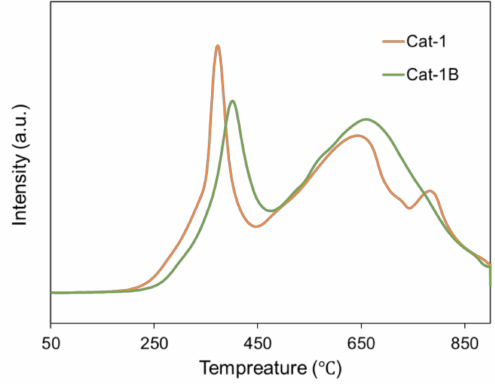
Figure 12. H 2 -TPR of profiles of Cat-1 and Cat-1B.